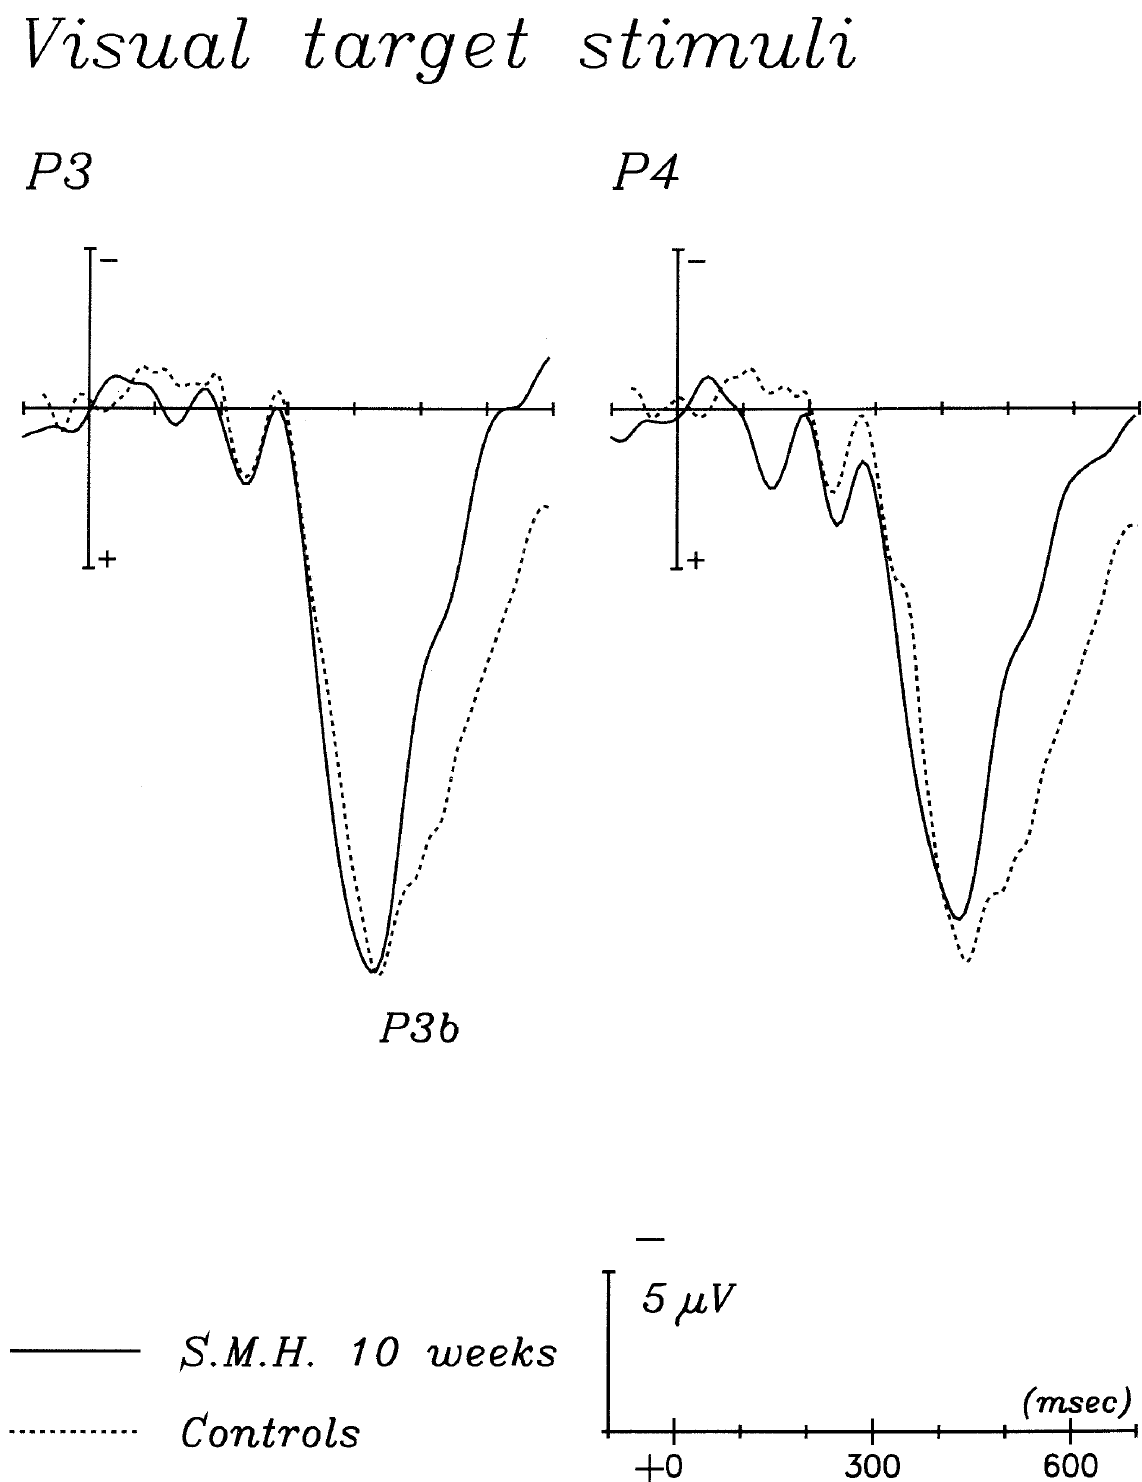
Fig. 7. Visual event-related potentials to detected targets: There is no difference between patient’s and control subjects’